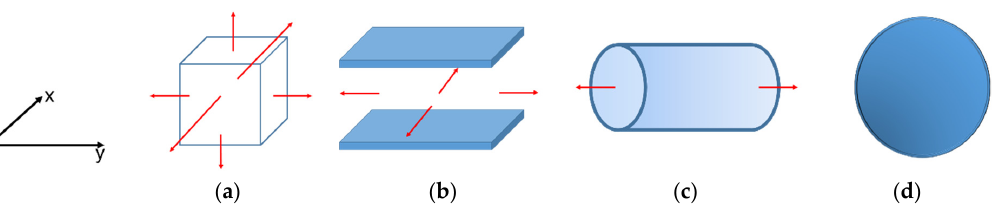
Figure 12. Schematic diagram of the studied systems: ( a ) infinite bulk system, ( b ) infinite slit pore, ( c ) infinite cylindrical pore, and ( d ) spherical pore. The red arrow lines represent the directions of periodic boundary conditions applied.